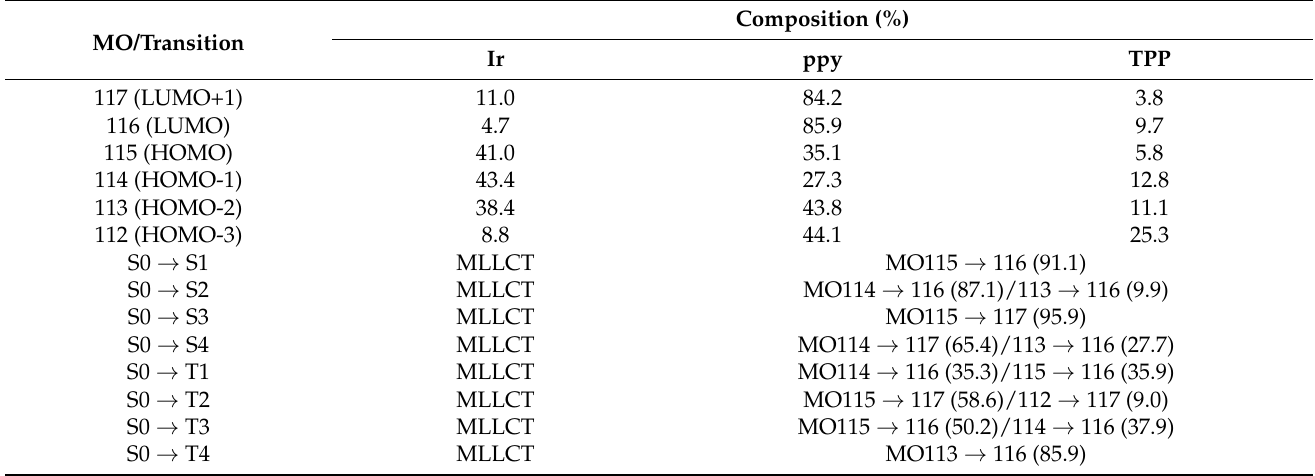
Table 4. Ir(ppy) 2 (TPP) percentage composition of singlet/triplet transitions and related molecular orbitals calculated at the RB3LYP/LANL2DZ